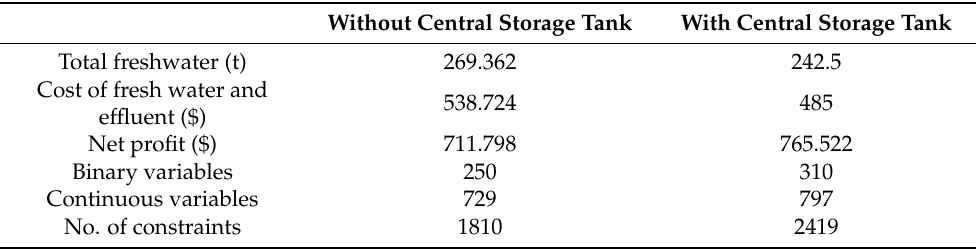
Table 2. Results obtained for the simultaneous approach for case study 1.